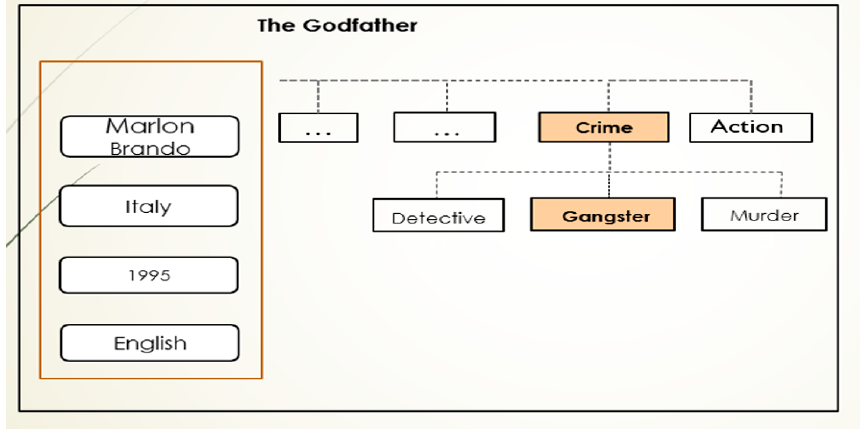
Figure 4. Movie genre categories and other flat features.